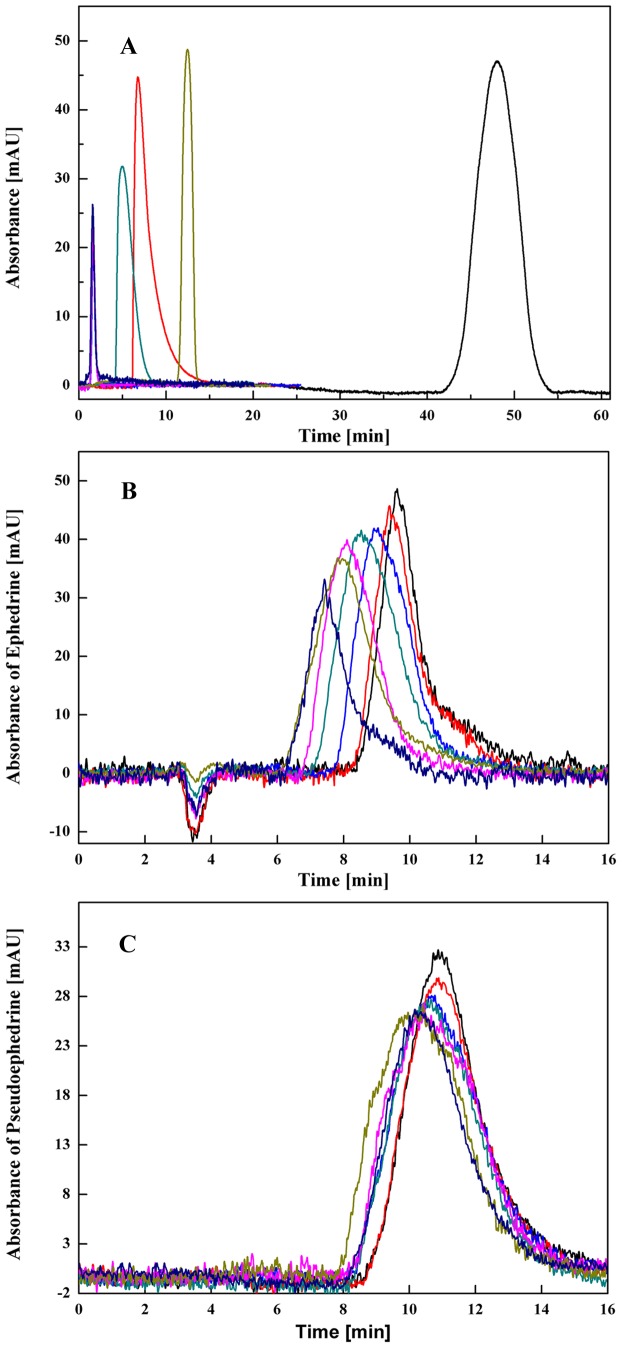
Representative chromatograms of control drugs, ephedrine and pseudoephedrine.A, Control drugs were eluted from β
2-AR column using 20 mM phosphate buffer (pH 7.4) as mobile phase at 0.2 mL/min. Non-retained peaks: sodium nitrite, terazosin, esmolol. Retained peaks: salbutamol, clorprenaline, tobuterol, bambuterol (left to right); B, Ephedrine eluted from β
2-AR column when the mobile phase containing ephedrine at different concentration (from right to left: 4, 8, 12, 20, 24, 30 and 34 µM); C, Pseudoephedrine eluted from β
2-AR column when the mobile phase containing ephedrine at different concentration (from right to left: 2, 4, 8, 12, 16, 24 and 30 µM).